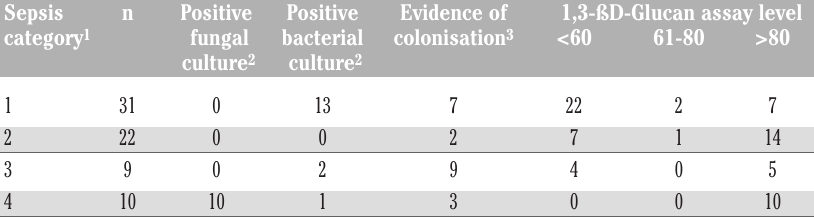
Table 2. Correlation of sepsis category with blood culture results and 1,3- b D-Glucan assay level